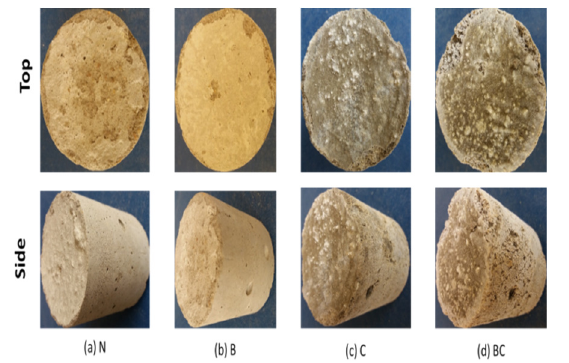
Fig. 6: Samples after Seven Days of Curing